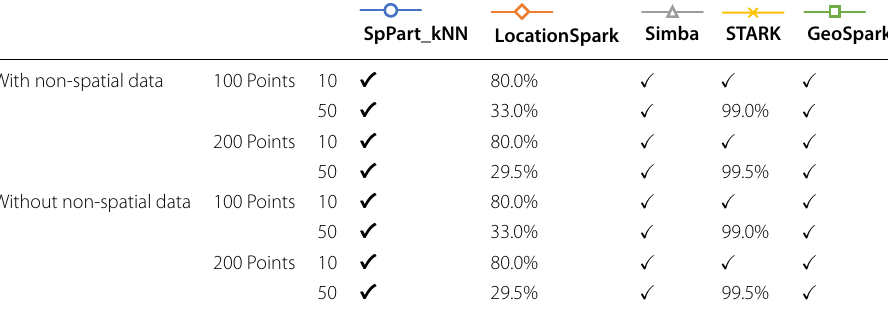
A (cid:31) indicates that the results completely agree with the baseline